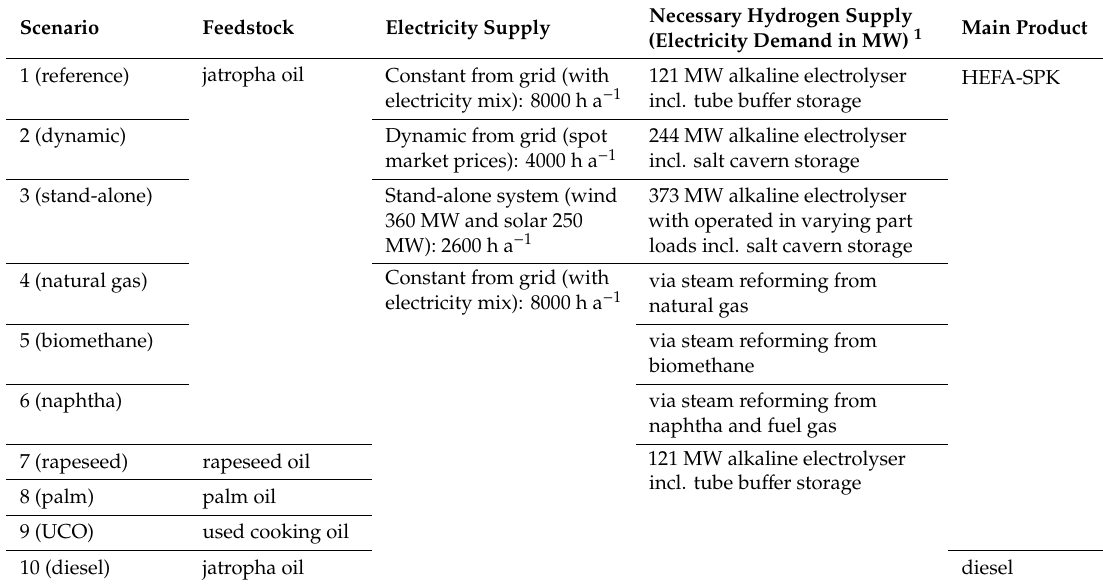
Table 1. Scenarios and their specific